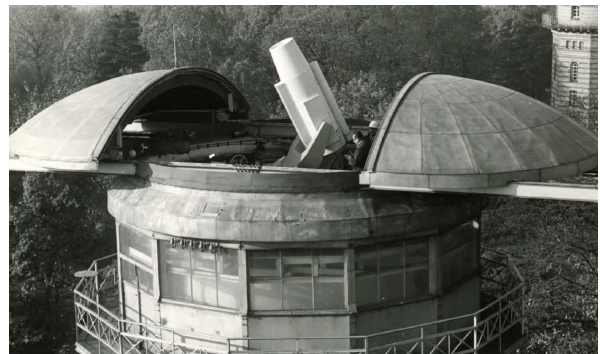
Figure 8. Helmert Tower, SBG photographic satellite camera, 1967 (photo: Zentralinstitut für Physik der Erde,